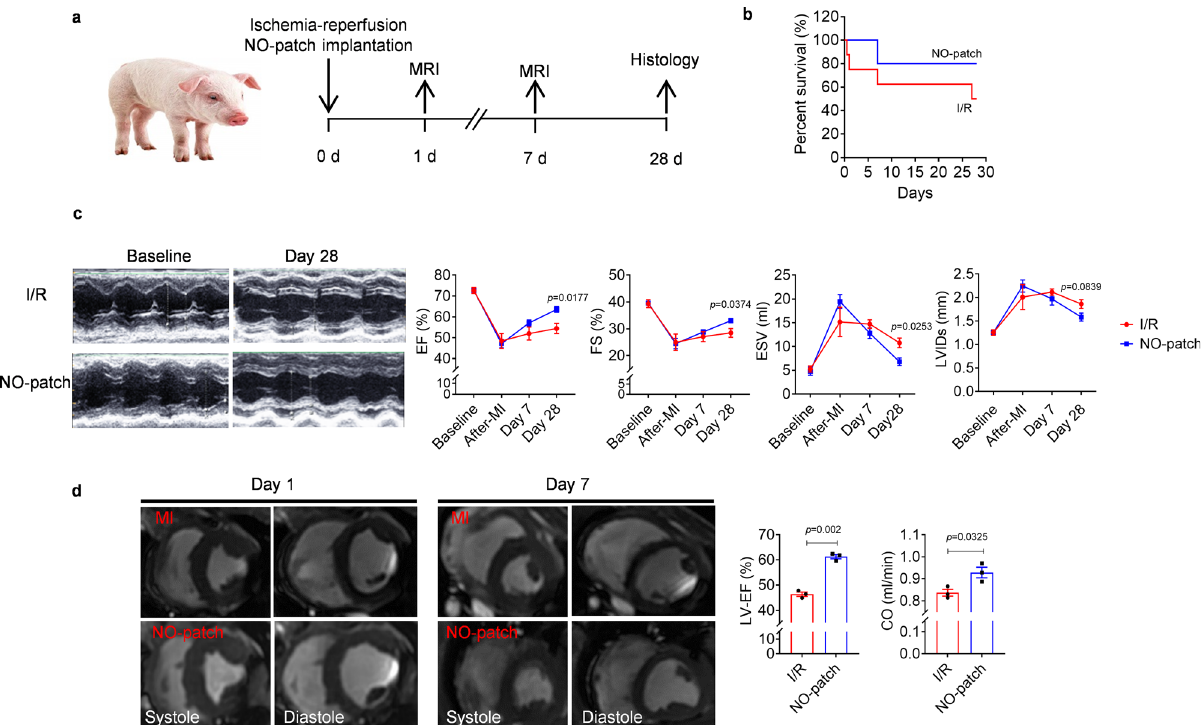
Fig. 8 Local NO delivery by nitrate-functionalized cardiac patches enhances survival rate and improves cardiac function in MI pigs. a Experimental schedule for the treatment of MI by epicardial implantation of NO patches. b Survival rates of pigs after MI with or without NO-patch treatment were recorded. NO patches improved survival of MI pigs. c Representative echo images re fl ecting cardiac function, and accordingly, left ventricular-ejection fractions (LV-EF), fraction shortening (LV-FS), left ventricular internal diameter at end diastole (LVIDs) and volume at diastole (ESV) were assessed ( n = 4 pigs in I/R group, n = 6 pigs in NO-patch group). d Representative MRI images obtained on day 1 and 7 (left, end systole; right, end diastole) and LV-EF as well as cardiac output (CO) were measured on day 7 accordingly ( n = 3 for each group). Data are expressed as mean ± SEM. Signi fi cant differences were detected by two-tailed student ‘ s t test at indicated time